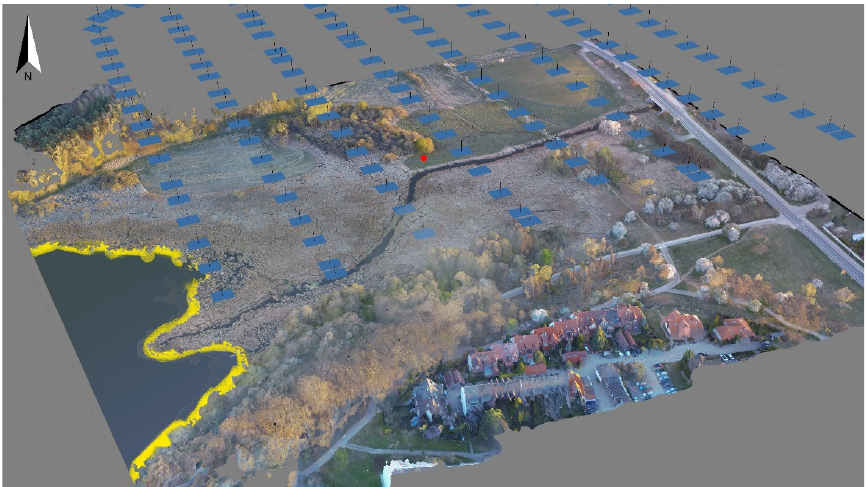
Figure 6. Location of photos (blue rectangles) over the three-dimensional model of the research area, outline of the reservoir (yellow line) and starting point (red point). During the flight, the air temperature was − 1.4 °C near the ground. The raid was carried out on 25 April 2021 at 3:54–4:01 UTC (+ 2 h local time) during sunrise. Figure 7 shows the temperature changes in the water mixing zone. During the meas- urement, the water temperature in the stream was about 1.5 °C higher than the water temperature in the reservoir. Even before it entered the lake, the temperature of Cybina’s water was dropping. The thermal image shows that the river spills in this place, creating many small channels and seeping through dense reeds towards the reservoir. Thus, tem- perature equalization took place before the river water entered the lake. Clear, rapid drops in temperature near 50 and 100 m from the beginning of the coordinate system in the diagram (Figure 7) result from the fact that the thermal image of the water is obscured by vegetation. The Cybina River is about 1.5 m wide, and the pixel size is about 25 cm, which means that the vegetation on the riverbank and the bottom interfere with the measure- ment of the water temperature. Pixel is an average value observed on a given unit area